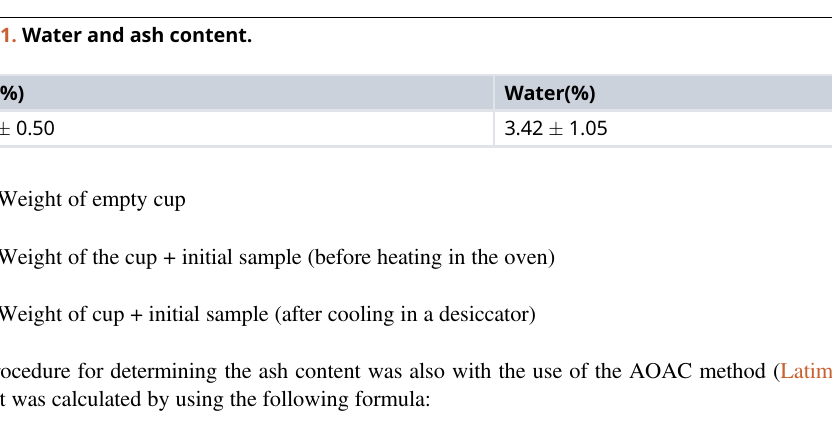
Figure 1. Graphical methodology of experimental study.